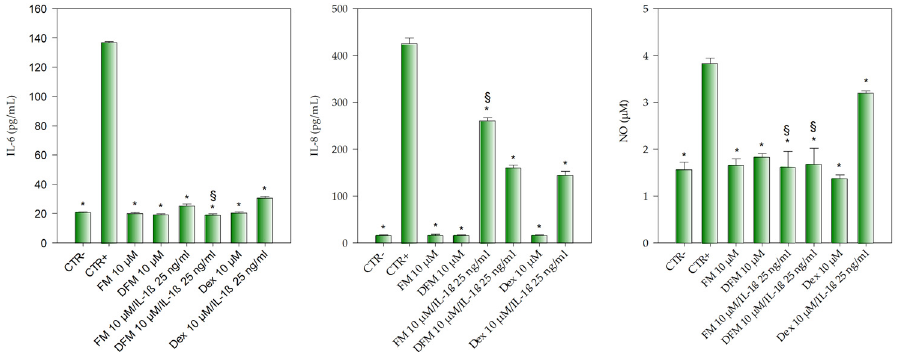
Figure 5. Evaluation of the anti-inflammatory activity of flavanones mix (FM, 10 µ M) and gastric plus duodenal digested flavanones mix (DFM, 10 µ M) in comparison with the reference anti-inflammatory drug dexamethasone (Dex, 10 µ M) by a cell-based assay carried out on Caco-2 transwell model. IL-1 β (25 ng/mL) was used to trigger the inflammation (CTR + ), whereas DMEM with 0.1% DMSO was used as negative control (CTR − ). Results were expressed as the concentration (pg/mL for IL-6 and IL-8, and µ M for NO) of inflammatory markers released after cell treatments ± S.D. of three independent experiments in triplicate ( n = 3); * p < 0.001 vs. CTR + ; § p < 0.001 vs. Dex 10 µ M/IL-1 β 25